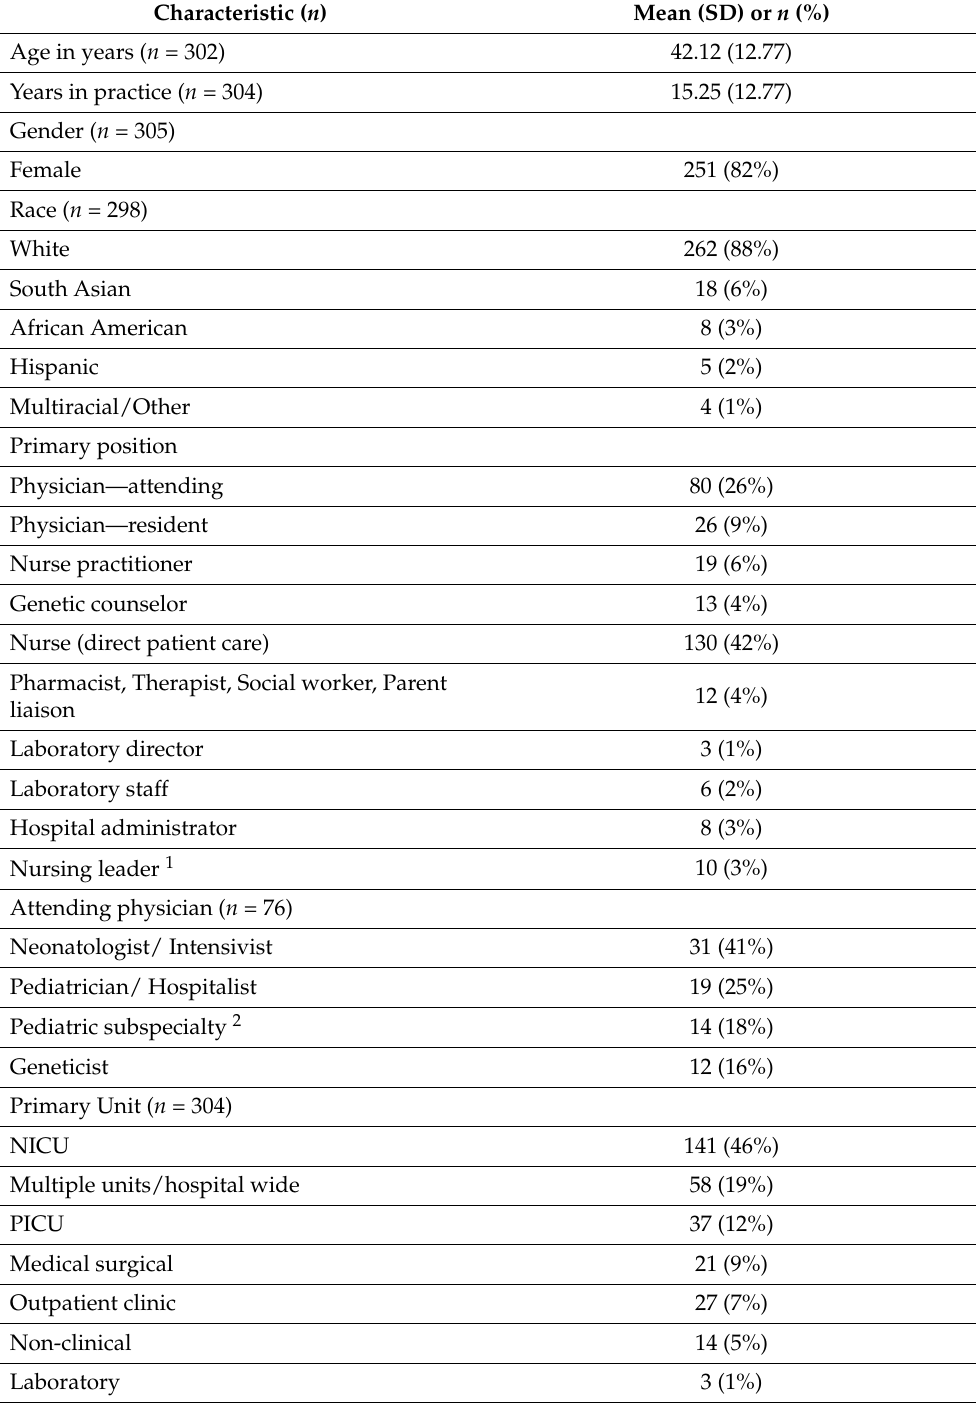
Table 1. Respondent characteristics (N =